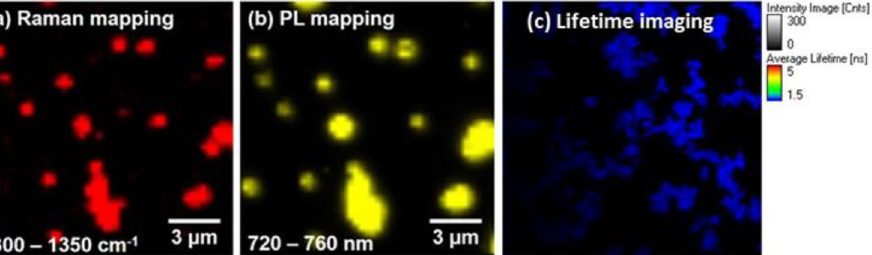
Figure 2. Imaging of ND@Au nanoparticles distributed along the substrate: mapping in pseudocolor of spatial distribution of ( a ) Raman signal in the 1300–1350 cm −1 range; ( b ) fluorescence in the 720–760 nm range. Excitation 488 nm wavelength laser, laser power at the sample ~ 3 mW; ( c ) Fluorescence lifetime imaging at 2-photon excitation with 800 nm wavelength laser, laser power at the sample ~ 0.5 mW.